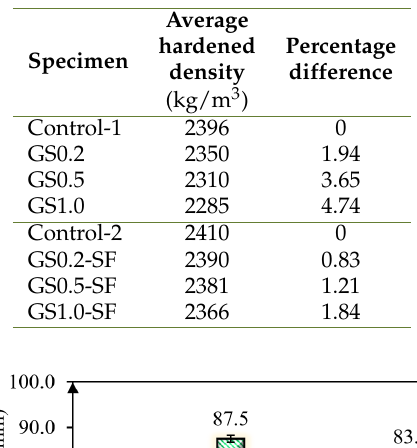
Table 2. Hardened density of CRT concrete